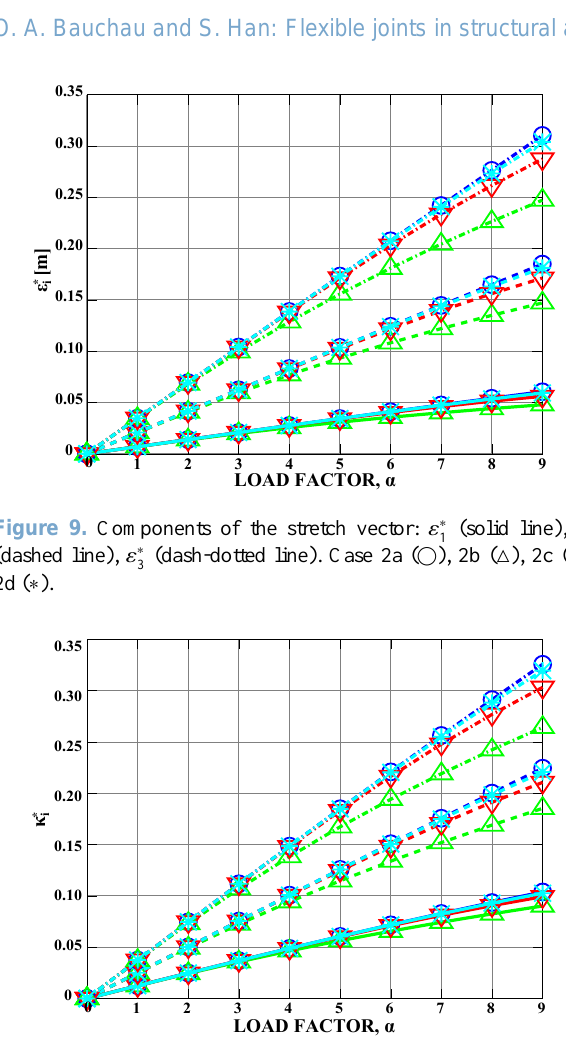
Figure 10. Components of the wryness vector: κ ∗ (dashed line), κ ∗ (dash-dotted line). Case 2a ( (cid:13) ), 2b ( 4 ), 2c ( 5 ), 2d 3 ( ∗ ).